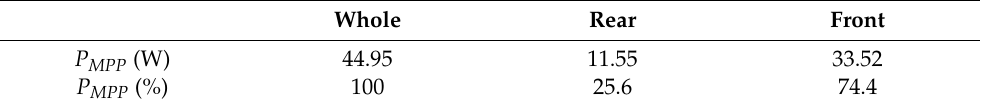
Table 14. A comparison of the generated power value of the test of the module—inclination of 75 ◦ angle mounted above the foil